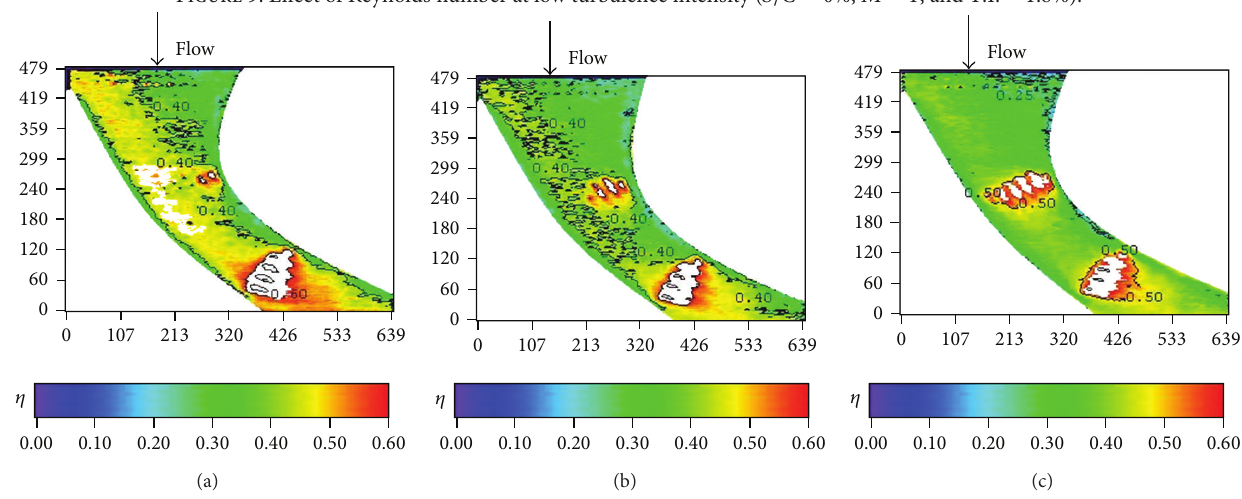
Figure 10: Effect of blowing ratio on local effectiveness at high turbulence intensity ( 𝑆/𝐶 = 0 %, Re = 124000 , and T . I . = 12 %). (a) 𝑀 = 0.5 . (b) 𝑀 = 1 . (c) 𝑀 = 2 .